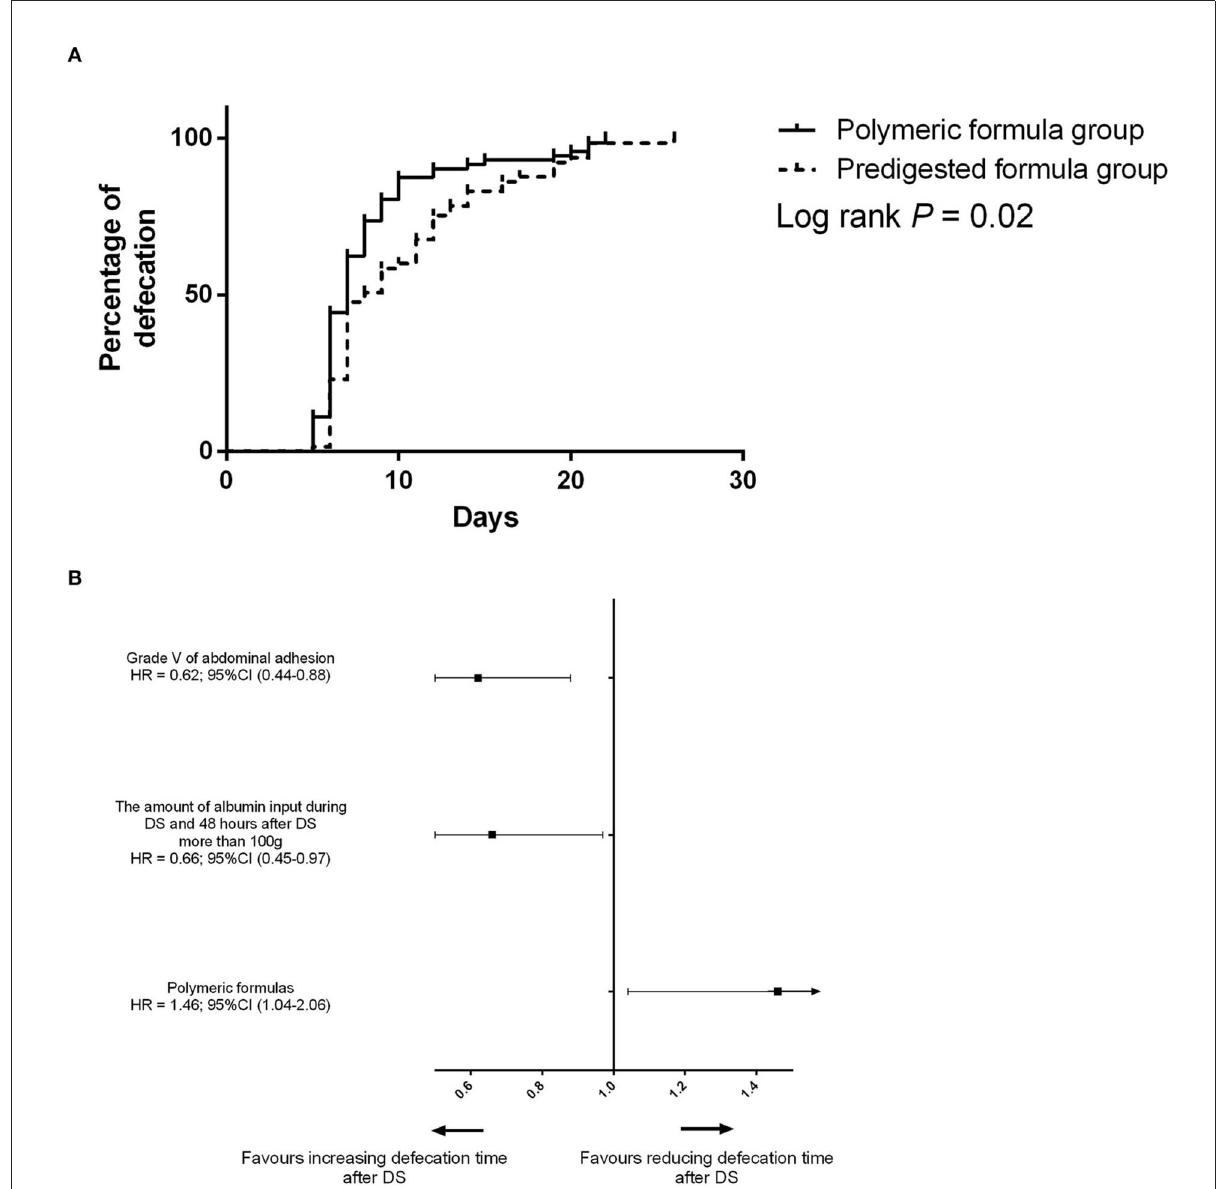
FIGURE3 (A) Difference of the defecation time between the predigested formula group and polymeric formula group. (B) Risk factors for defecation before